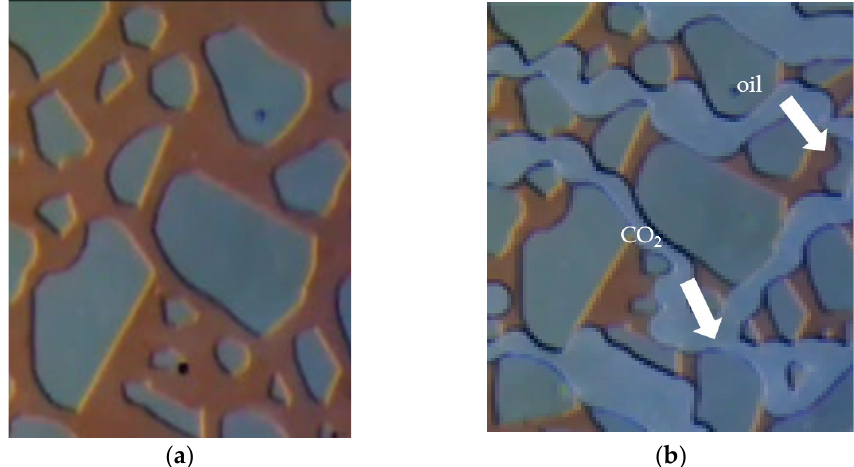
Figure 11. 10 MPa 110 °C Microscopic experiment chart: ( a ) Before gas injection; ( b ) After flowback.